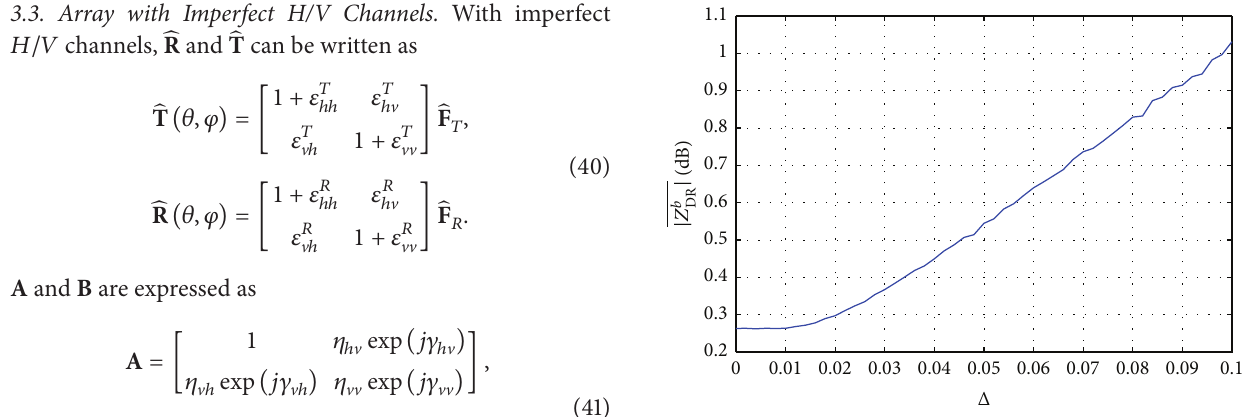
Figure 10: |𝑍 𝑏 DR | of a single spherical scatterer with imperfect 𝐻/𝑉